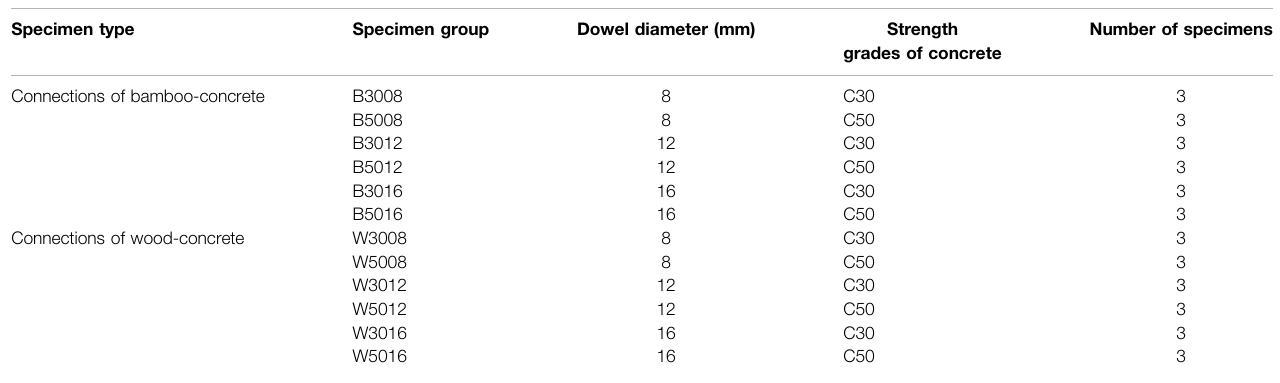
TABLE 3 | Specimen parameters. Specimen